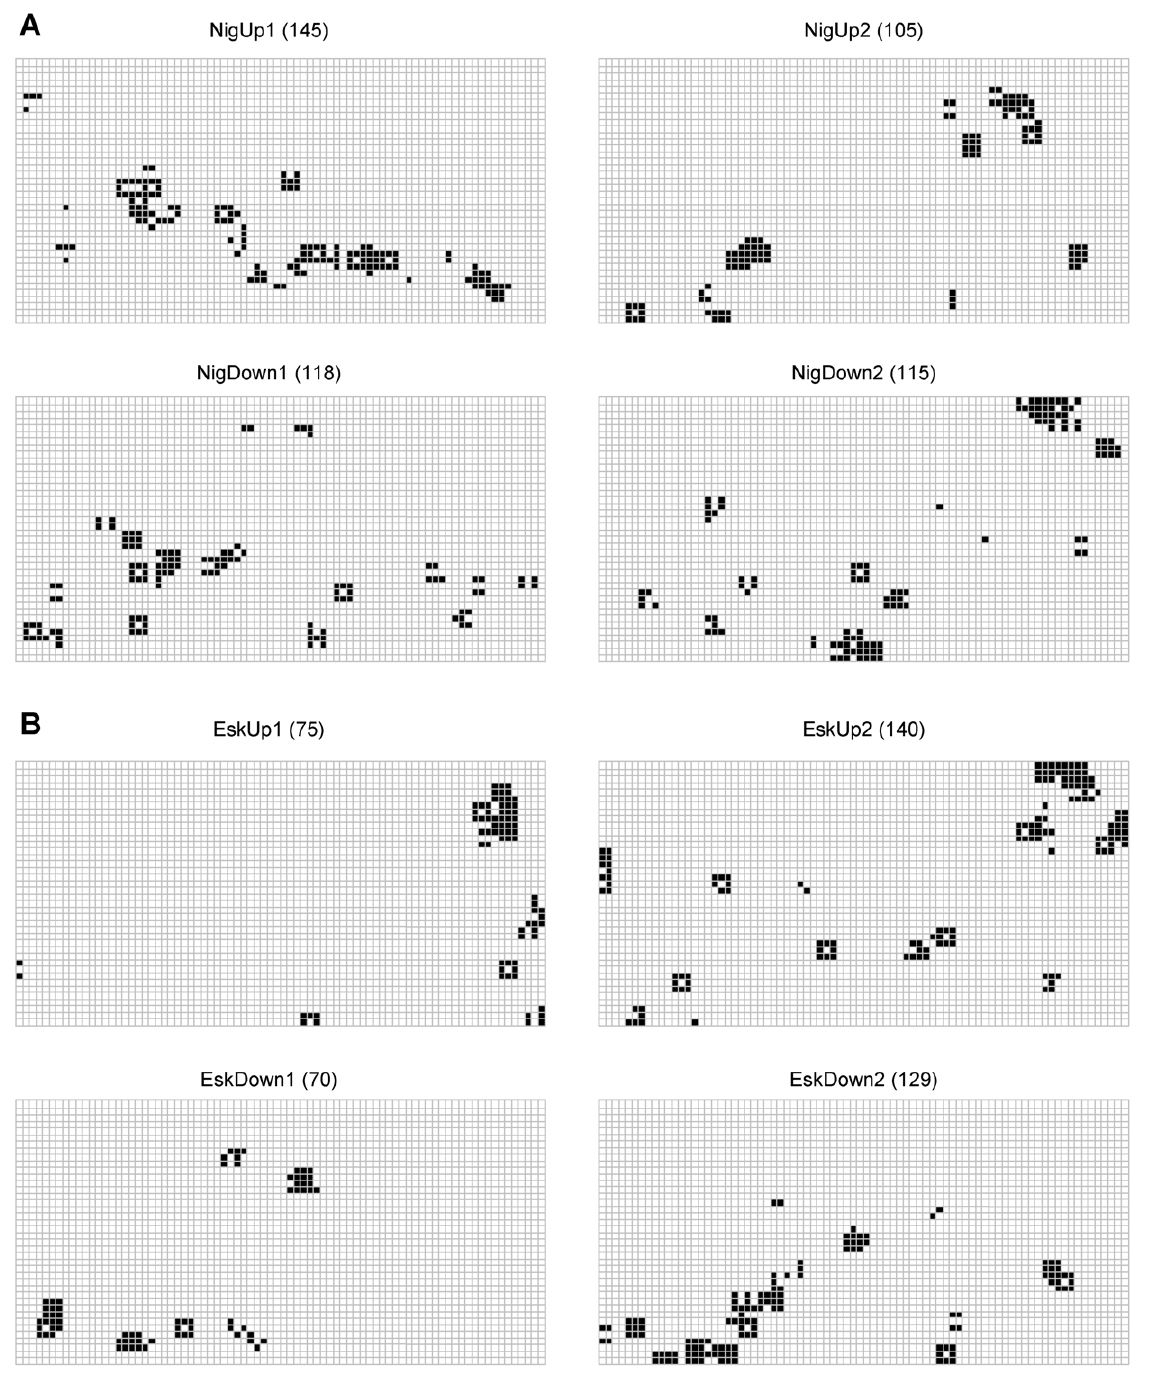
Figure 1. Juvenile Cytisus hot spots detected with local G i * statistic in F.nigrescens or F.eskia grasslands. Number of hot spots is given in brackets. doi:10.1371/journal.pone.0028652.g001 nigrescens (scales between 0.75 and 2.5 m) while negative associa- tions were found with F. eskia (from 0.5 to 3.25 m). For the remaining cover types, we found contrasting associations with juvenile Cytisus depending on grassland type (Figure 3). In F.